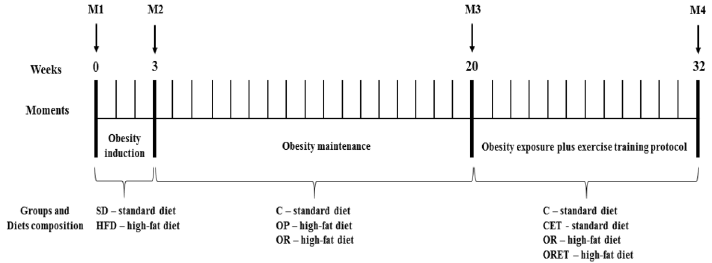
Figure 1. Experimental protocol timeline of 32 weeks. The weeks are represented by individual bars. Initially, animals were distributed into two groups, fed on standard diet (SD) and high-fat diet (HFD). After 3 weeks of experimental protocol (obesity induction), body weight of SD and HFD presented a statistical difference, and this moment was considered the onset of obesity and obesity resistance. The obesity resistance and obesity maintenance period lasted 17 weeks and then the animals were redistributed into two more groups for the practice or not of exercise training, maintaining the same diets and composing the groups: control (C); control submitted to the exercise training protocol (CET); obese-resistant (OR); and obese-resistant submitted to the exercise training protocol (ORET). M1: Beginning of the experimental protocol, induction to obesity; M2: Beginning of obesity; M3: Characterization of obesity prone (OP) and obesity resistance (OR), redistribution of groups to the beginning of the exercise training protocol (CET and ORET); M4: End of the experimental protocol, euthanasia, and start of study analyses.